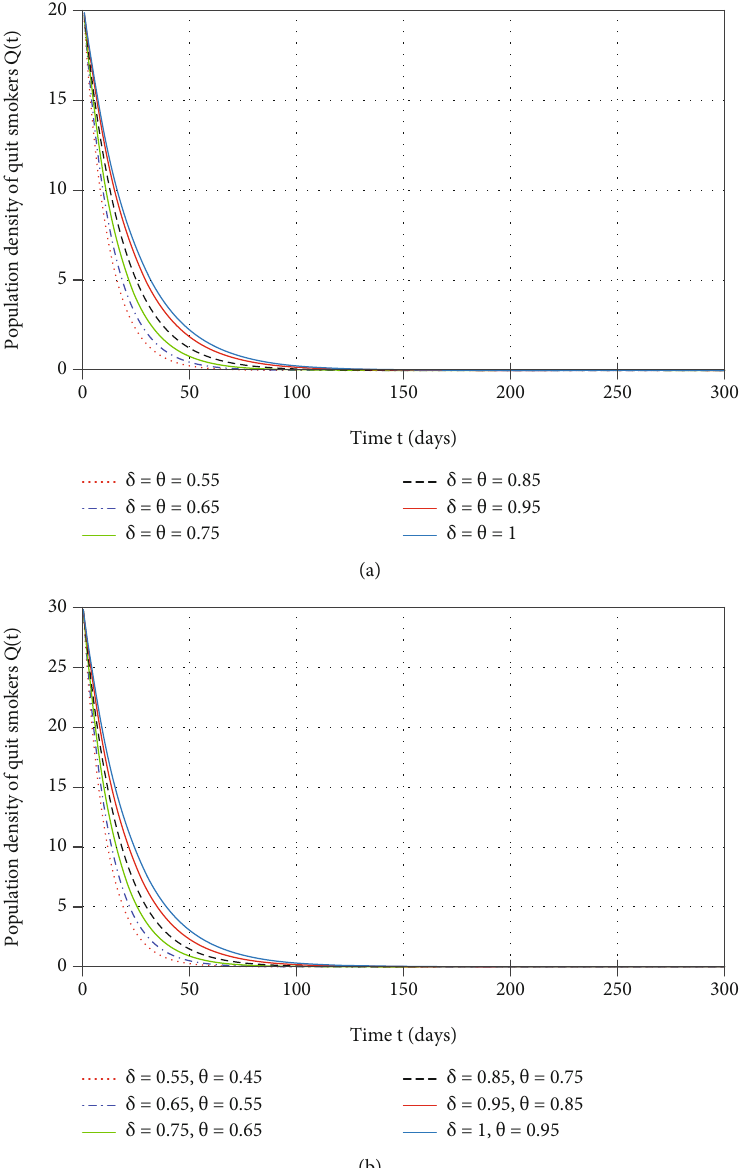
= 20 , 30 in the model under investigation 0